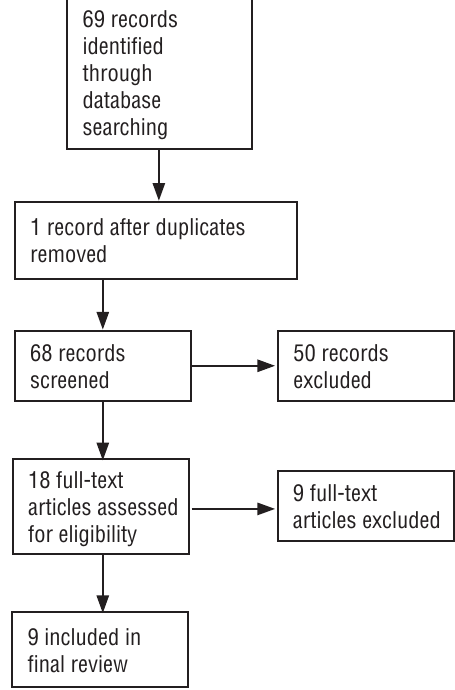
figure 1 - search method for suitable